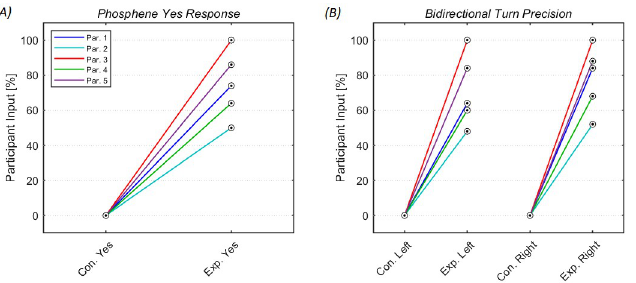
Fig 7. Navigation accuracy. (A) Individual results in response to the first voice-automated question asking participants if they perceived a phosphene. If so, participants will press the right pushbutton indicating “yes.” Phosphenes were only evoked during the experimental condition. (B) Results showing participants ability to accurately turn either left or right based on phosphene